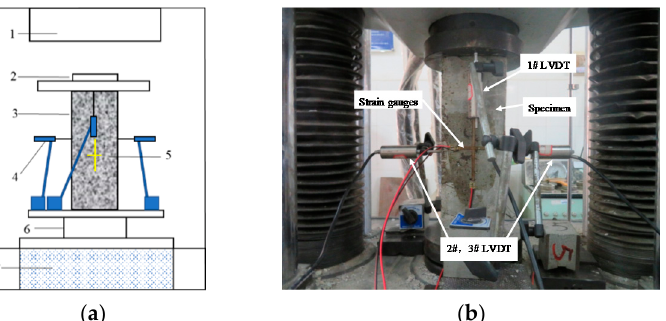
Figure 1. Uniaxial compressive test setup: ( a ) schematic of setup for loading; ( b ) test equipment. Note: 1—Force Transducer; 2—Steel Platens; 3—Specimen; 4—Displacement Sensor; 5—Strain Gauges; 6—Bottom Backing Plate; 7—Electro-Hydraulic Servo Actuator.